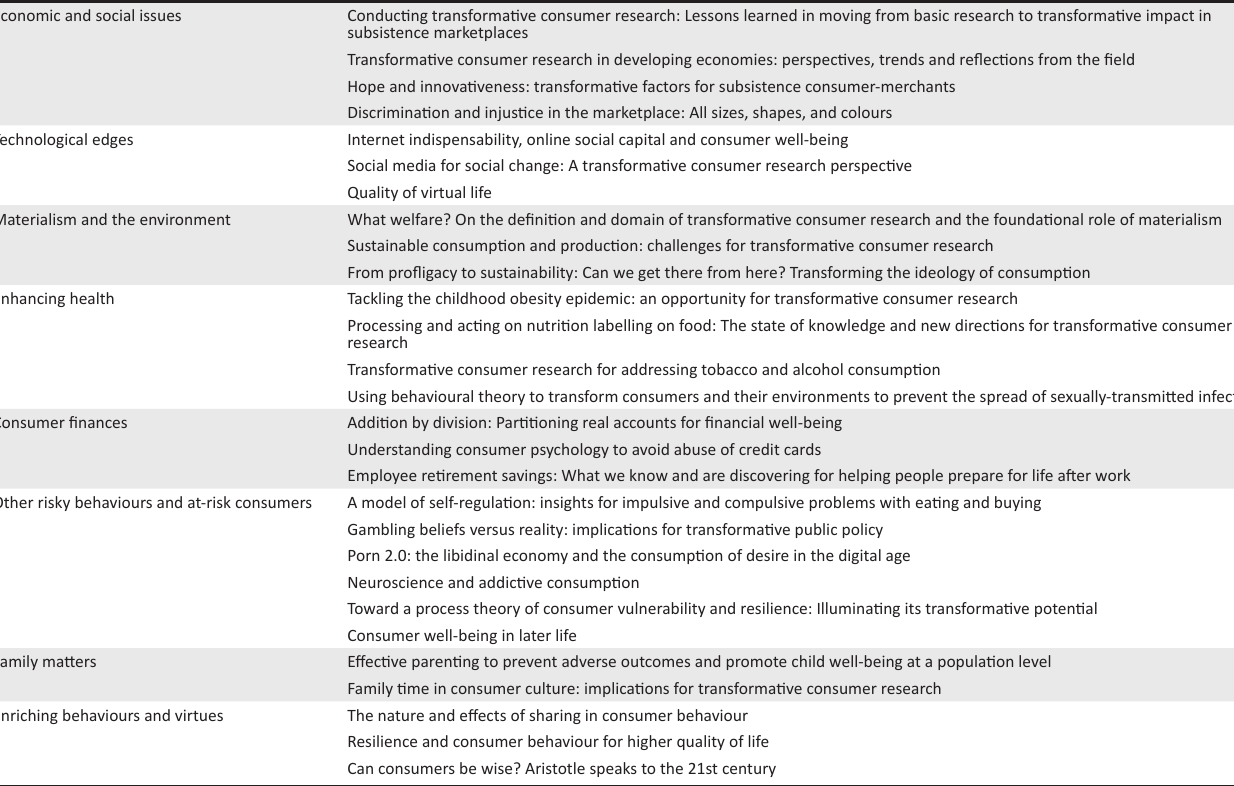
TABLE 2: Examples of topics covered in transformative consumer